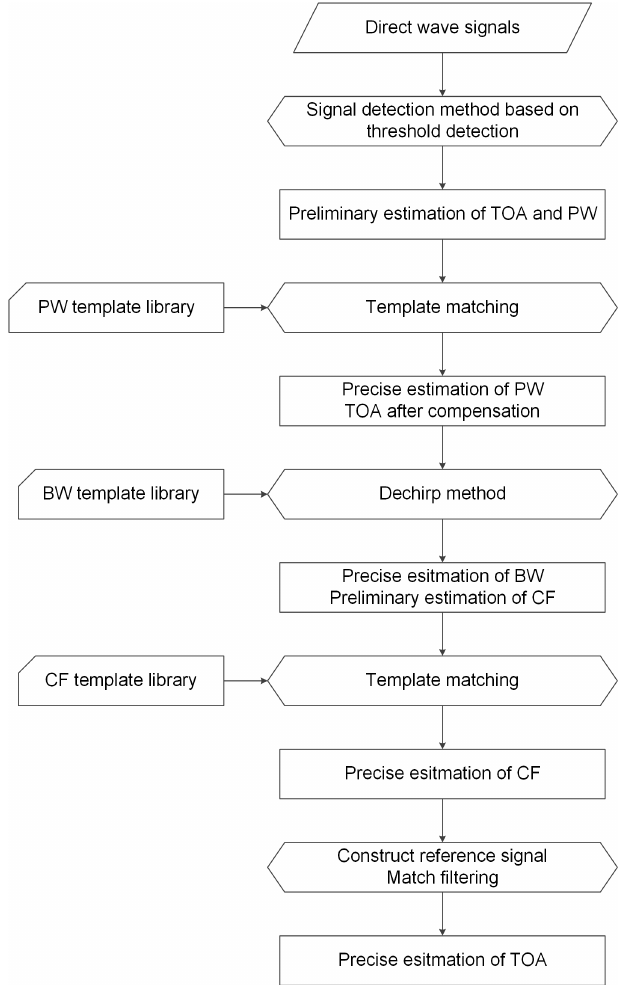
Figure 6. Flow chart of direct wave parameter estimation